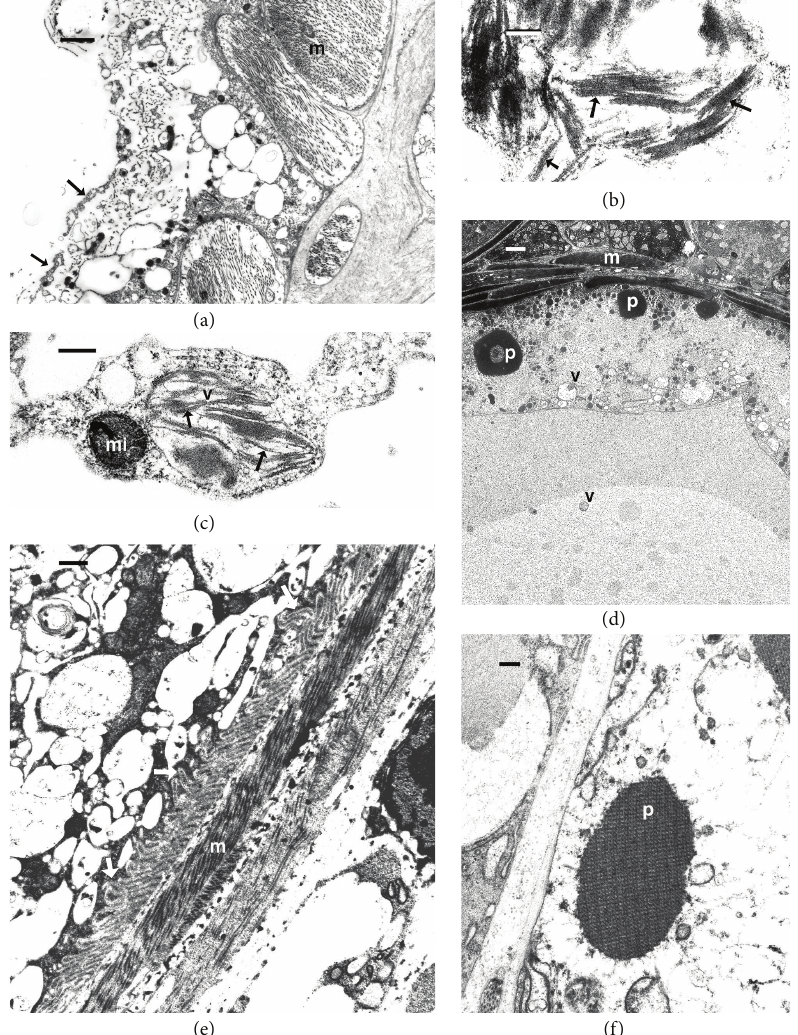
Figure 4: Clear vesicle of Aplysia californica ((a)–(c)) and white vesicle of A. juliana ((d)–(f)). (a) An electron-lucent lumen surrounded by a thin layer of cytoplasm bordered by muscle. The cytoplasm frequently had an electron dense material (arrows) against it. ((b) and (c)) Parallel arrays of sheets (arrows) contained within a cytoplasmic vacuole (c) within a clear vesicle. (d) Vesicle contents are frequently separated into three zones of decreasing density, the one closest to the muscle wall containing protein crystals. (e) Vesicle cell membrane highly infolded with the folds (white arrows) containing filamentous, low electron dense material. (f) Protein crystals are not enclosed by a membrane. m, muscle; mi, mitochondrion; p, crystalline protein; v, vacuole. Scale bars: (a) = 2 𝜇 m; ((b) and (c)) = 200 nm; (d) = 2 𝜇 m; (e) = 0.5 𝜇 m; (f) = 0.25 𝜇